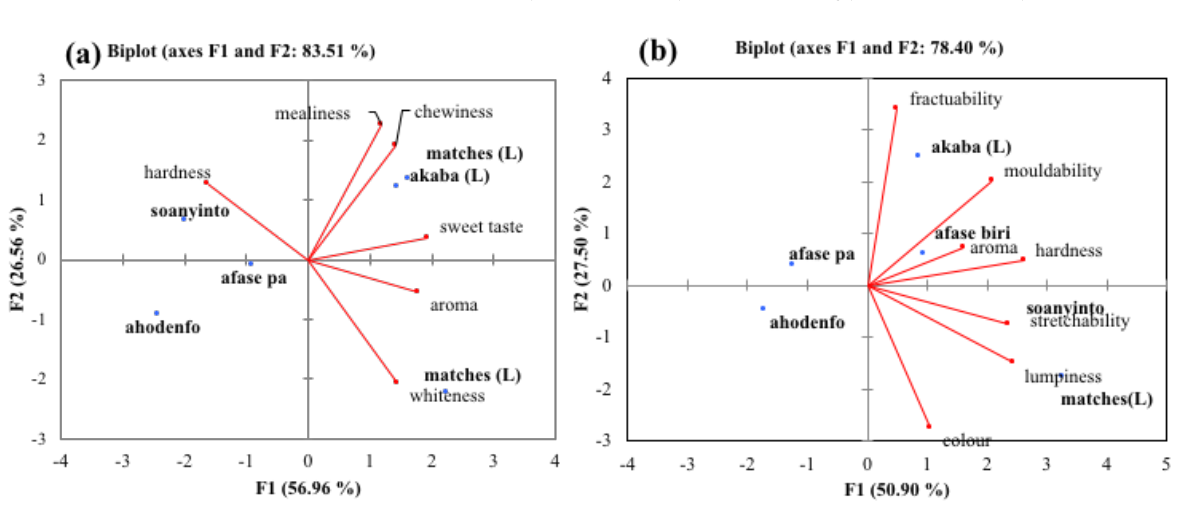
Figure 2. Principal component of descriptors of quality for ( a ) boiled and ( b ) pounded D. alata vari- eties. Yam varieties — CRI afase pa, CRI afase biri, CRI afase pa, CRI ahodenfo, CRI soanyinto, akaba matches . L = local